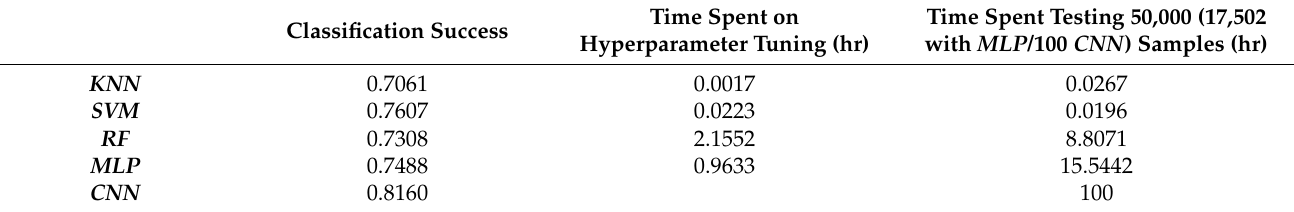
Figure 7. Comparison of classification success versus the number of iterations for the five models [23] and authors elaboration. Table 2. Classification results in the five